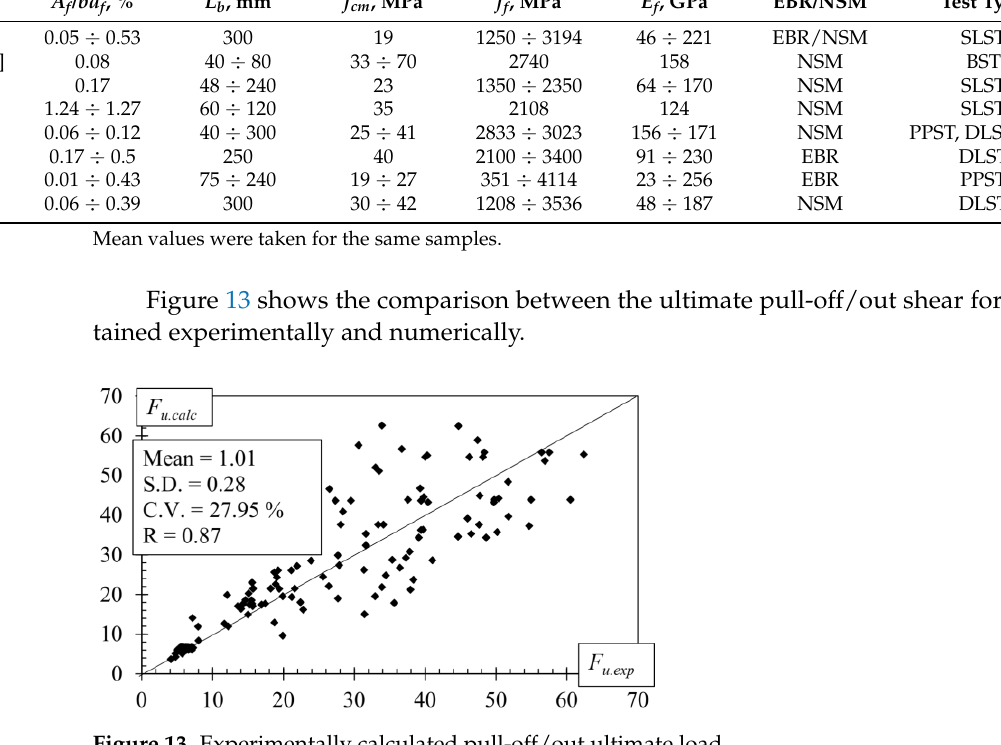
Figure 13. Experimentally calculated pull-off/out ultimate